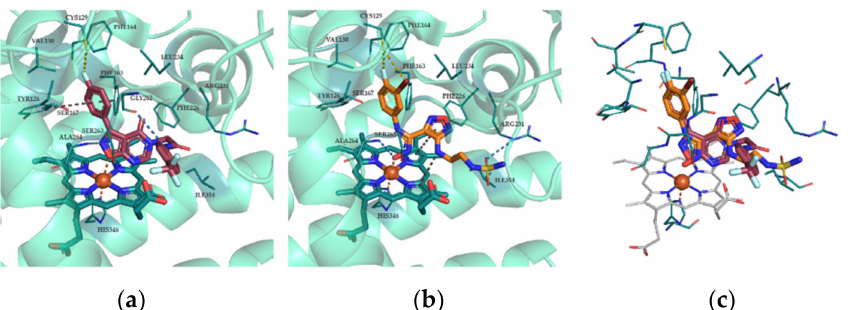
Figure 4. Comparison of predicted binding mode for 23 , crystal structure of IDO1 with 1 and superposition of 1 and 23 . ( a ) Compound 23 (purple) was docked into the active site of IDO1 (pdb code 5WN8, cyan) with protein ligand docking software GOLD 2020.0 (CCDC, UK). Possible interactions formed were additionally predicted with Protein-Ligand Interaction Profiler [35] and are: a coordinate bond (orange) with heme iron; H-bonds (blue) with Gly262 and Ala264; π - π stacking (grey) with Tyr126 and Phe163 and several hydrophobic interactions (not shown) with lipophilic milieu. 4-fluorophenyl ring of 23 was positioned similarly to 3-bromo-4-fluorophenyl ring of 1 ; therefore, we additionally predicted another interaction (olive) between halogen and Cys129. ( b ) Crystal structure of 1 (orange) with IDO1 (cyan, 5WN8) with reported interactions: a coordinate bond (orange) with heme iron; H-bonds (blue) with Ala264 and Arg231; π - π stacking and cation- π interaction (both grey) between heme and 1 , and interaction between halogens of F and Br with Cys129. ( c ) Superposition of 1 (orange) and 23 (purple) shows similar binding into the active site of IDO1 (heme, grey; amino acid residues responsible for interactions,